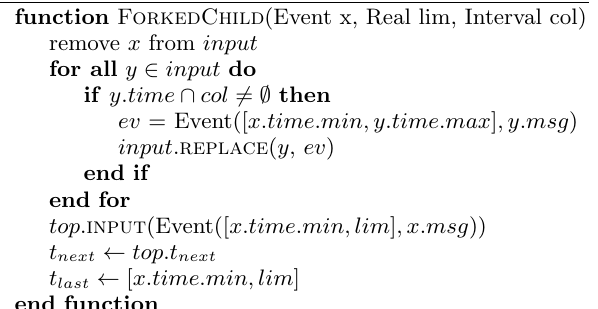
Algorithm 4 Abstract Root-Coordinator handling of events colliding before the scheduled transition